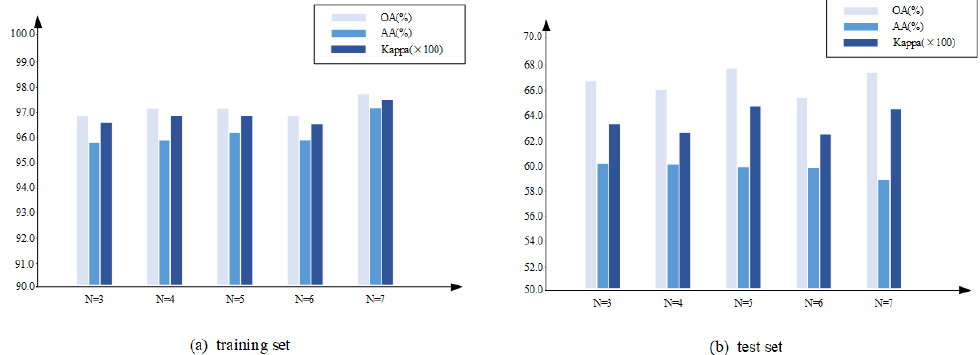
Figure 10. Mean values of OA, AA, and kappa based on three tests about network depth N, evaluated on the training set ( a ) and test set ( b ) in the So2Sat LCZ42 dataset,